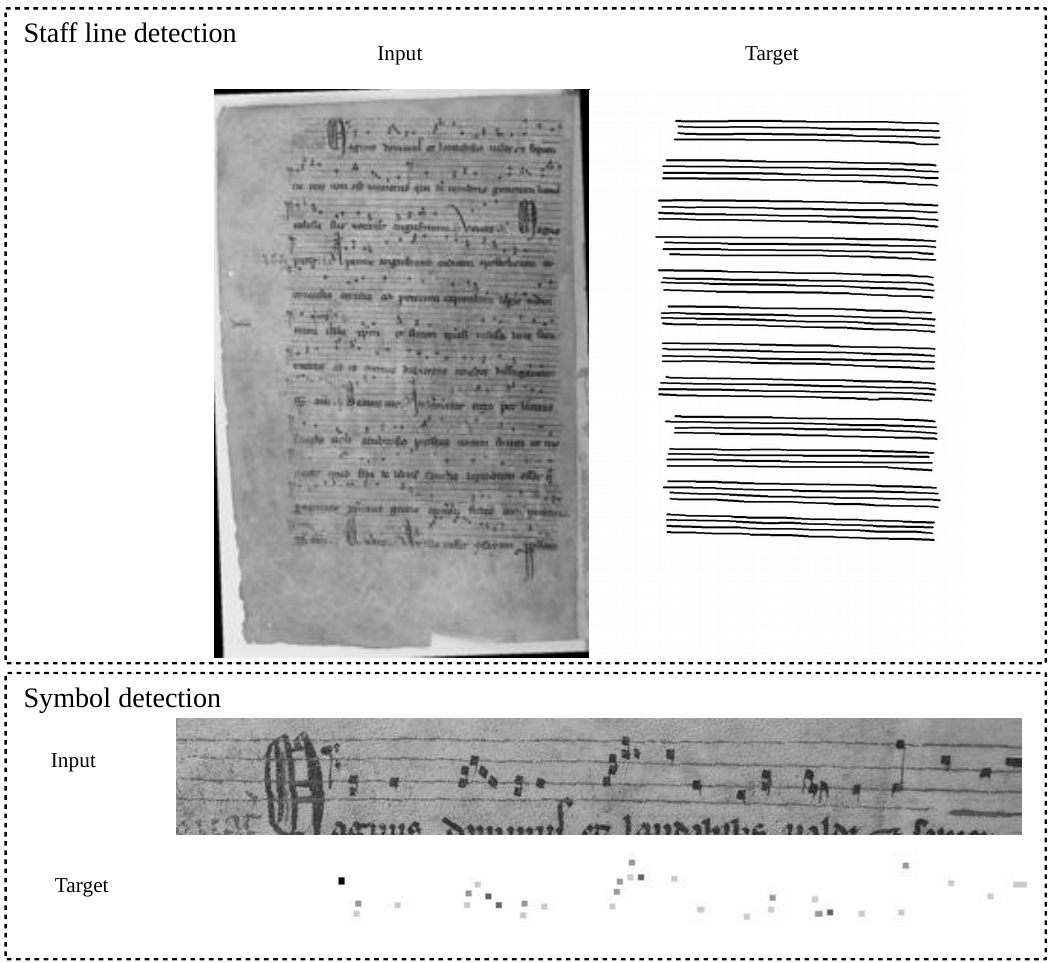
Figure 5. GT pairs of input and target for training the FCN. The upper box shows an example for the staff line detection where the FCN acts on the full page. The staff lines in the GT are drawn as black lines in the target binary image. The symbol detection, instead, expects an image of a single line as input. The different grey levels of the target represent the symbol classes, for example the darkest level indicates a F-clef, while the brightest level marks a NC which is the start of a